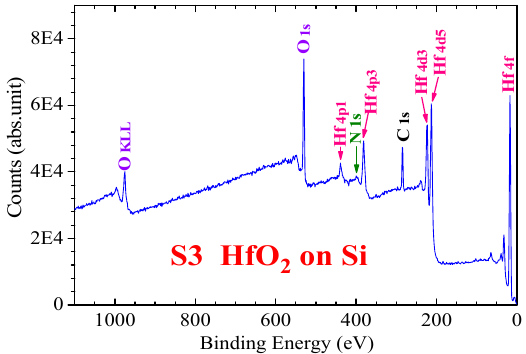
Figure 1. XPS survey scan of the HfO 2 film of the sample S3.